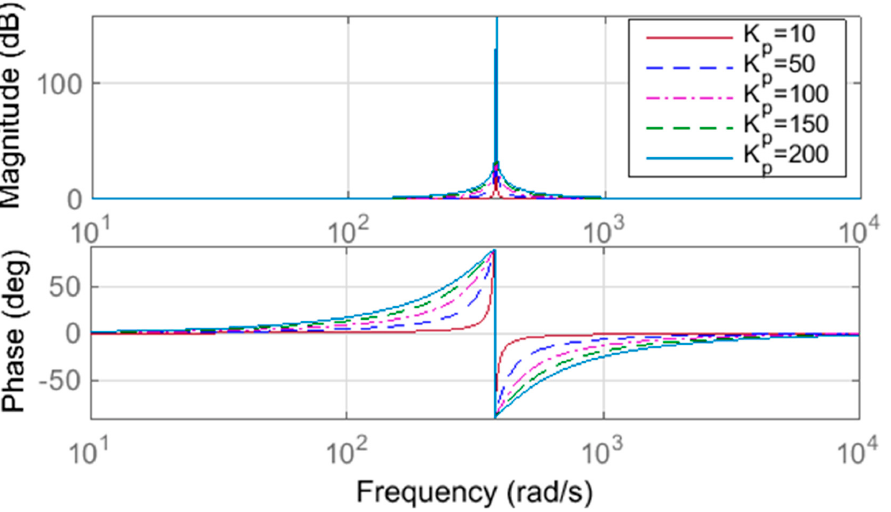
Figure 10. Frequency response of PR controller as a function of K p changes.